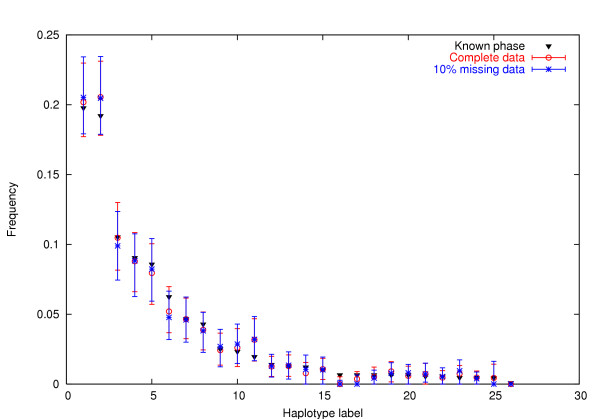
Seven loci SNP data with 10% missing alleles. 95% CIs for haplotype frequencies estimated from seven loci SNP phase-unknown data with 0% and 10% missing data. Frequencies derived from phase-known data also shown.